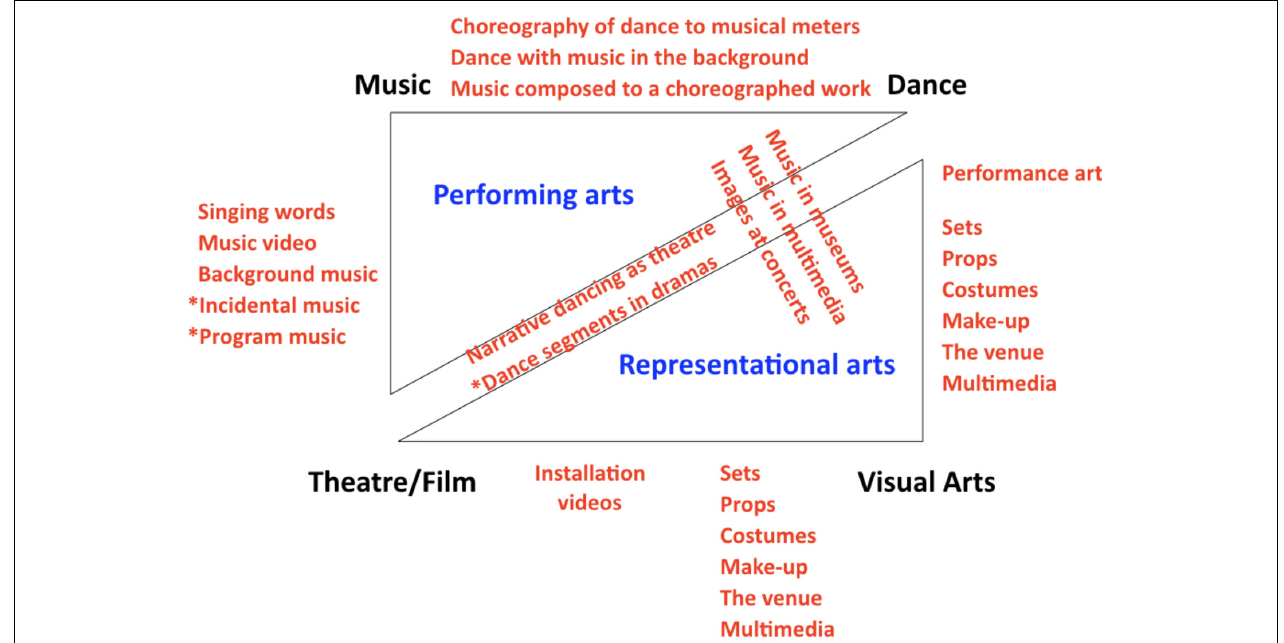
FIGURE 3 | Interactions among the arts. The same double-triangle representation from Figure 1 is shown here. In red text are the six types of two-way interactions between artforms. Whereas most interactions involve simultaneous combinations of artforms, the interactions marked with asterisks (i.e., incidental music, program music, and dance in verbal dramas) are those that tend to occur in alternation with one another.